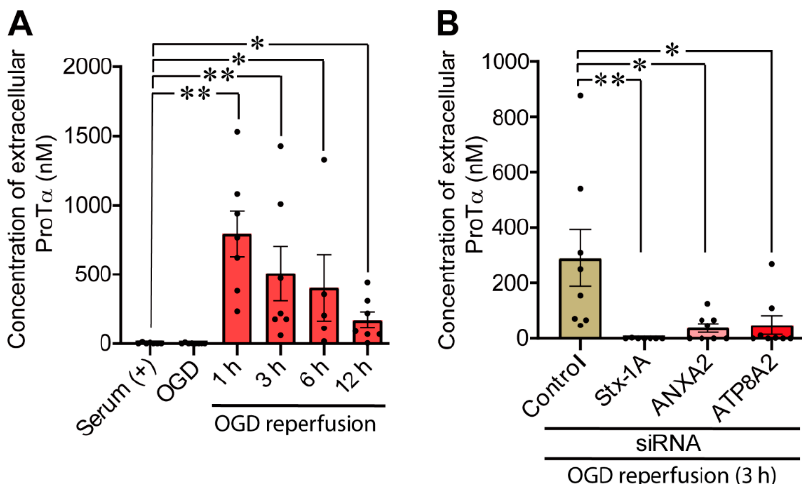
Figure 5. Knock-down of key molecules prevents ischemia-induced release of ProT α from neurons. ( A ) Time course of extracellular release of ProT α from cortical neurons in primary culture after the oxygen glucose deprivation (OGD)–reperfusion stress. Neurons were seeded on 24-well plate at a density of 5 × 10 5 cells/cm 2 and the volume of conditioned medium for normal and OGD treatment was 500 µ L. Conditioned medium (CM) was collected 2 h after OGD treatment and at various time points after reperfusion and the concentration of ProT α in the medium was measured by proximity extension assay, as previously described [18]. Results show the concentration of ProT α released from 9.5 × 10 5 neurons in 500 µ L of conditioned medium. To calculate the extracellular concentration of ProT α ; a calibration curve was created by preparing a set of standard solutions with known concentrations of recombinant ProT α protein. ProT α was rapidly released after reperfusion. Data are presented as the mean ± S.E.M. from a Steel test. * p < 0.05 and ** p < 0.01. n = 7 experiments (serum (+)), n = 8 experiments (2 h after OGD), n = 7 experiments (1 h after reperfusion), n = 7 experiments (3 h after reperfusion), n = 5 experiments (6 h after reperfusion), n = 7 experiments (12 h after experiments). ( B ) Evidence for the blockade of OGD-reperfusion stress-induced extracellular release of ProT α by the gene knock-down of Stx-1A, ANXA2 and ATP8A2. CM was collected from siRNA- transfected cortical neurons 3 h after reperfusion and the concentration of ProT α was measured. Data are presented as the mean ± S.E.M. Steel test. * p < 0.05 and ** p < 0.01. n = 8 experiments (Control), n = 7 experiments (Stx-1A), n = 8 experiments (ANXA2), n = 8 experiments